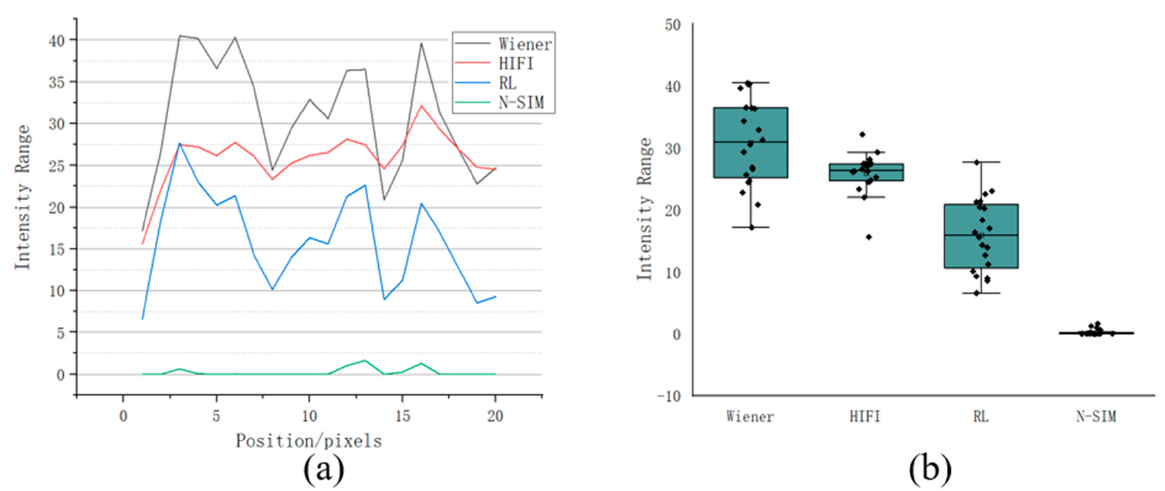
Figure 8. ( a ) Wiener-SIM, HIFI-SIM, RL-SIM and N-SIM are respectively used to reconstruct the sample image, and the fluctuation of fluorescence intensity on the yellow line in the background area is analyzed. ( b ) The distribution of fluorescence intensity of each pixel in the yellow line.